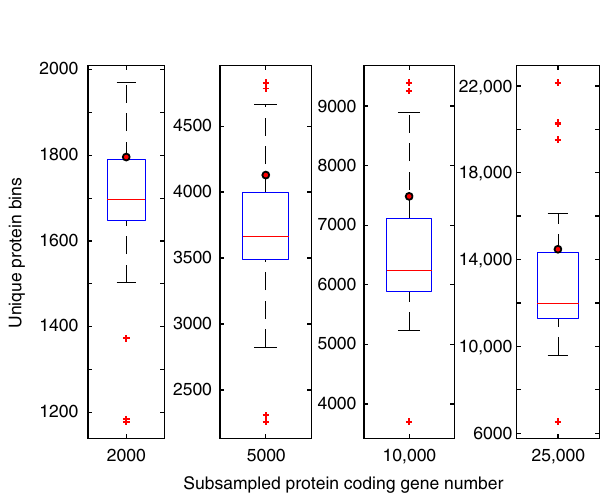
Fig. 4 Comparison of protein family diversity in SJ3 relative to other chemosynthetic YNP hot spring metagenomes. Boxplots show the distribution of unique protein bins after subsampling 48 chemosynthetic YNP metagenomes at multiple depths at the levels shown below each box plot. Note that the Y-axis scales differ between panels. The values for SJ3 are shown as red circles. Red lines indicate the median for each distribution, while the boxes represent the interquartile range between the 25th and 75th percentiles. Whiskers show the full range of the data, not considering outliers and outliers are shown as red crosses. Source data are provided within the source data fi le accompanying this manuscript